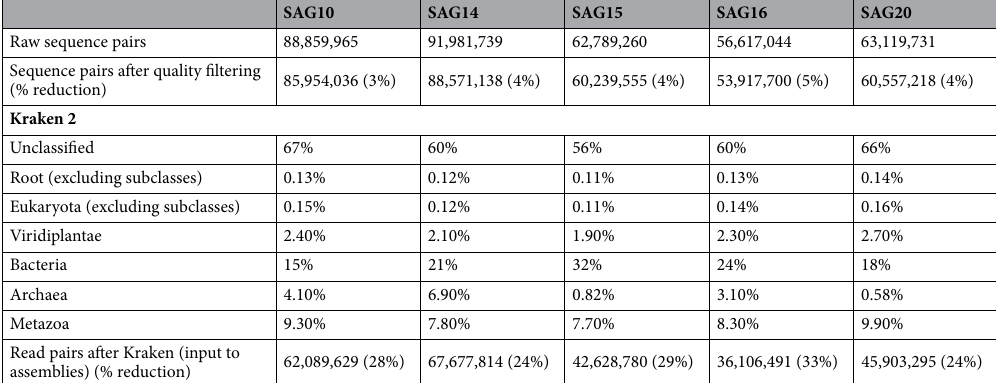
Table 2. Illumina sequencing of genomic DNA from A. acetabulum amplified using droplet MDA. Quality trimming reduced the number of paired reads by 3–5% per SAG. Between 67–76% of the read pairs per sample were classified by Kraken2 as “unclassified”, root (excluding subclasses), Eukaryota (excluding subclasses), or Viridiplantae (including subclasses) and were considered as potential A. acetabulum sequences (numbers above the dashed line). These reads were used as input to the genome assemblies. Below the dashed line are shown the most abundant groups of non- Acetabularia reads classified by Kraken2.